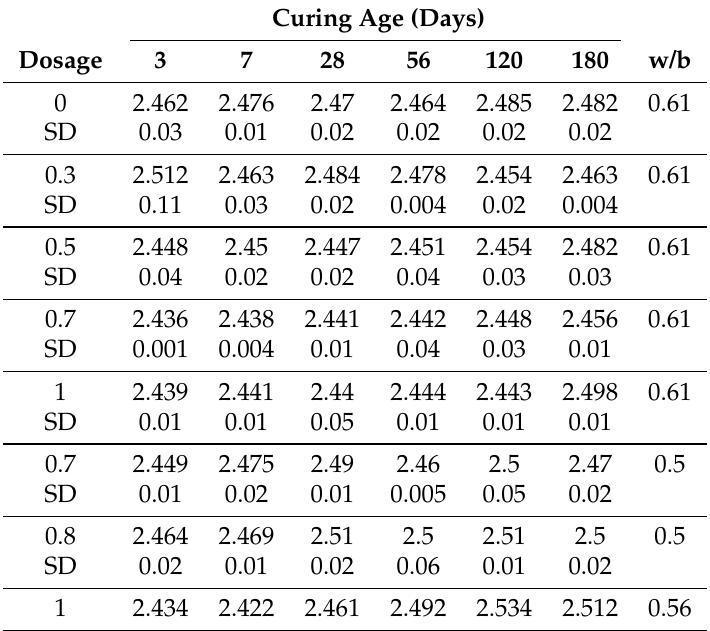
Table 3. Mean density ( × 10 3 kg/m 3 ) of concrete samples with different dosages of